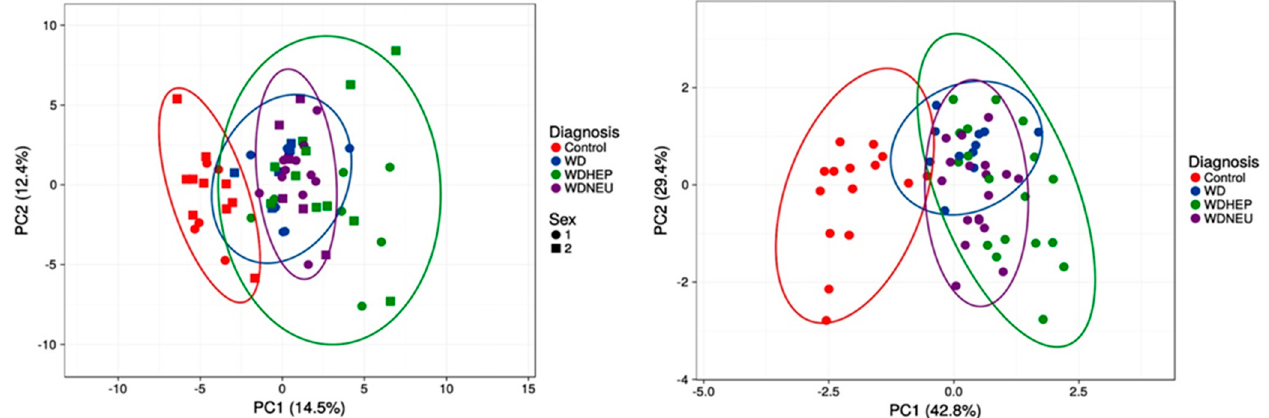
Figure 3. Principal component analysis of the four diagnostic groups based on all outcomes and the selected nine amino acid and derivatives from the decision tree. PCA (utilizing ClustVis 2.0 [40]) was applied to the test dataset by utilizing all outcomes as input (top panel; n = 62 points). Unit variance scaling was applied to rows; singular value decomposition with imputation was used to calculate principal component analysis (to both top and bottom panels). Other options were set as it follows: no transformation of data was performed, and no collapse of columns with similar annotations was performed; maximum percentage of unavailable data allowed in both rows and columns was set at 99.99; row centering; no removal of constant columns; row scaling was based on unit variance scaling, and the PCA method was calculated by using singular value decomposition. The x -axis and y -axis show principal component 1 and principal component 2 that explain 14.5% and 12.4% of the total variance, respectively. Prediction ellipses possess 0.95 probability, and a new observation from the same group will fall inside the ellipse (both panels). All other data including PCA variances and loadings are summarized under Tables S4 and S5, respectively. Bottom panel was performed by using only the BCAA/AAA ratio, glutamate, asparagine, and taurine levels. The x -axis and y -axis show principal component 1 and principal component 2 that explain 42.8% and 29.4% of the total variance, respectively. All other data including PCA variances and loadings are summarized under Tables S6 and S7, respectively.